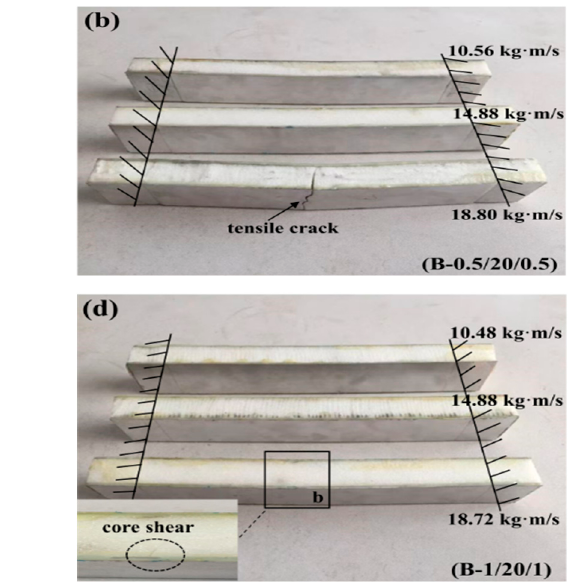
Figure 7. The impact force–time curve of the sandwich beams: ( a ) B-(0.5/10/0.5); ( b ) B-(0.5/20/0.5); ( c ) B-(1.0/10/1.0); ( d ) B-(1.0/20/1.0).